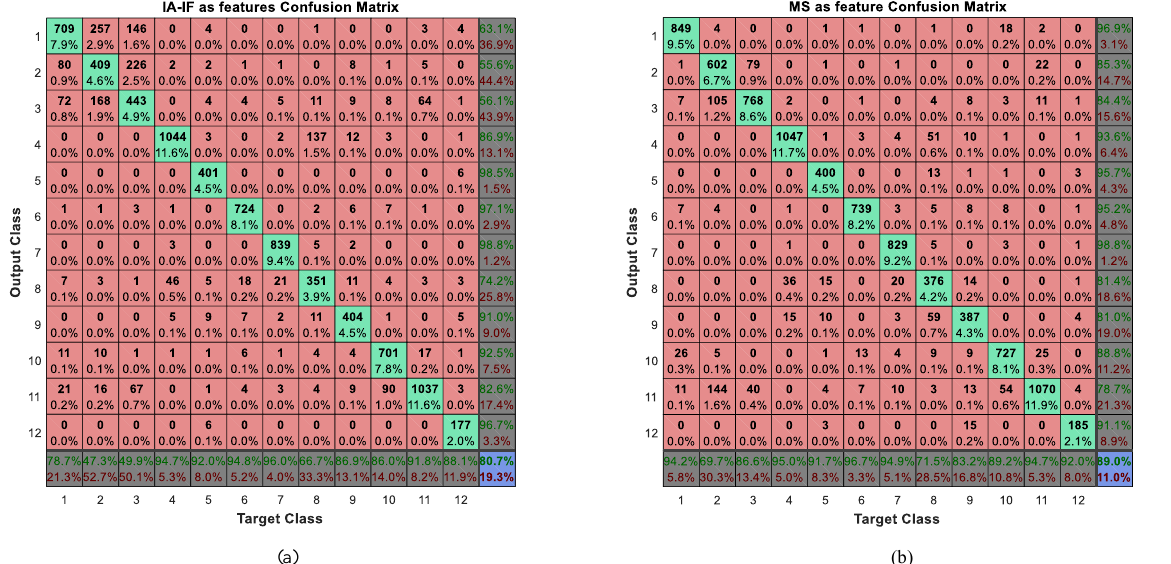
Figure 10. Confusion matrices of using MS, instantaneous amplitude-instantaneous frequency (IA-IF) as features ( a ) IA-IF as features; ( b ) MS as feature. The diagonal cells (green cells) show the number and percentage of correct classification. The red cells show where the classifier has made mistakes. The dark cells in the bottom row show the accuracy of each annotated class, while the dark cells in the right column show the accuracy of each recognized class. The purple cell in the bottom right of the matrix shows the overall accuracy.